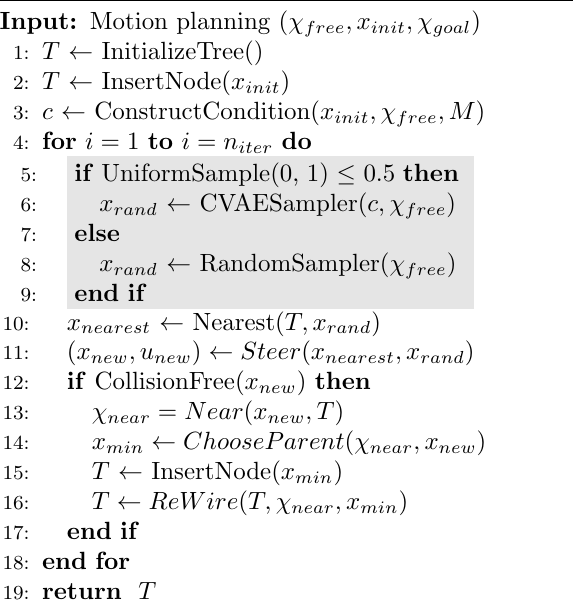
Algorithm 1 Online execution of RRT* with learned sampler